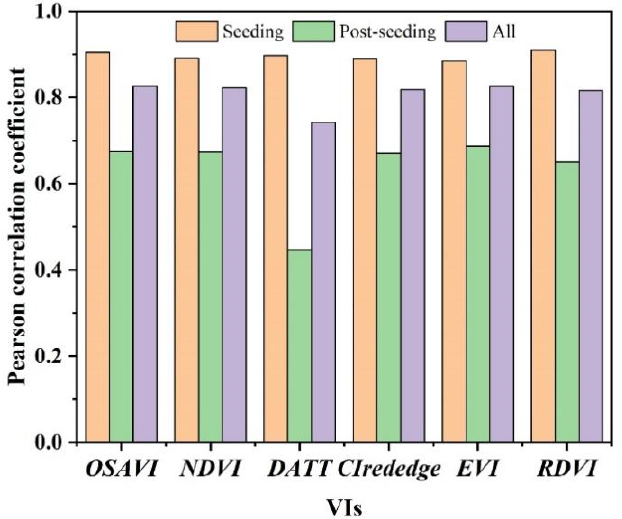
Figure 7. Pearson correlation coefficient between vegetation indices and aboveground biomass. Table 4. Prediction results of LR, RF, and PLS with the optimal VI across all di ff erent growth stag- es.